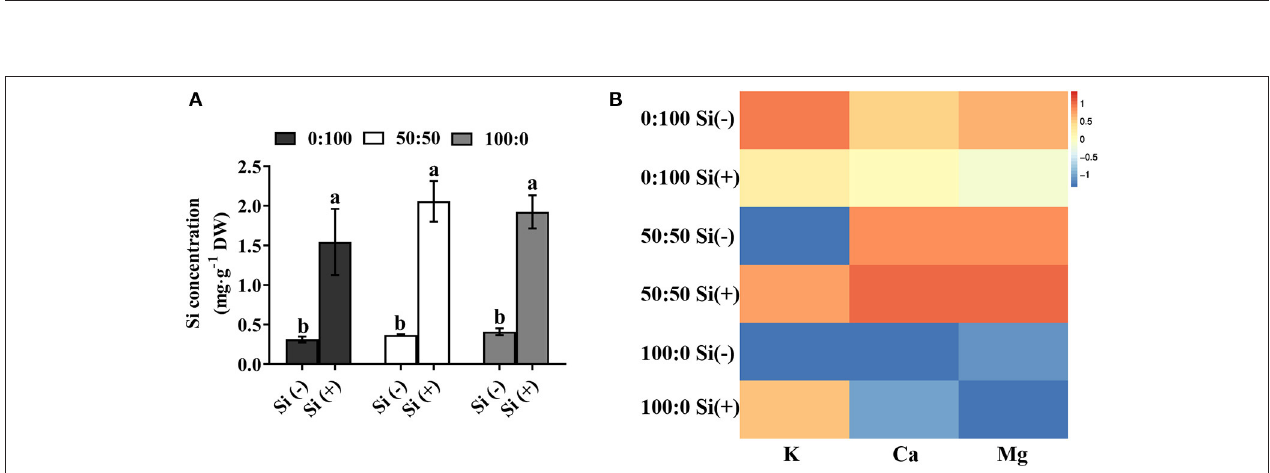
FIGURE 4 | Contents of (A) Si and (B) other ions (K, Ca, Mg) as affected by the three different NH + 4 :NO − 3 ratios with or without Si supplementations. Data in (A) are means of three independent replicates ± SD; statistical significance was denoted by different lowercases according to Duncan’s multiple range test at p = 0.05. Concentrations of K, Ca, and Mg in plants were compared and illustrated via a heatmap; original data was averaged, Log2 normalized and